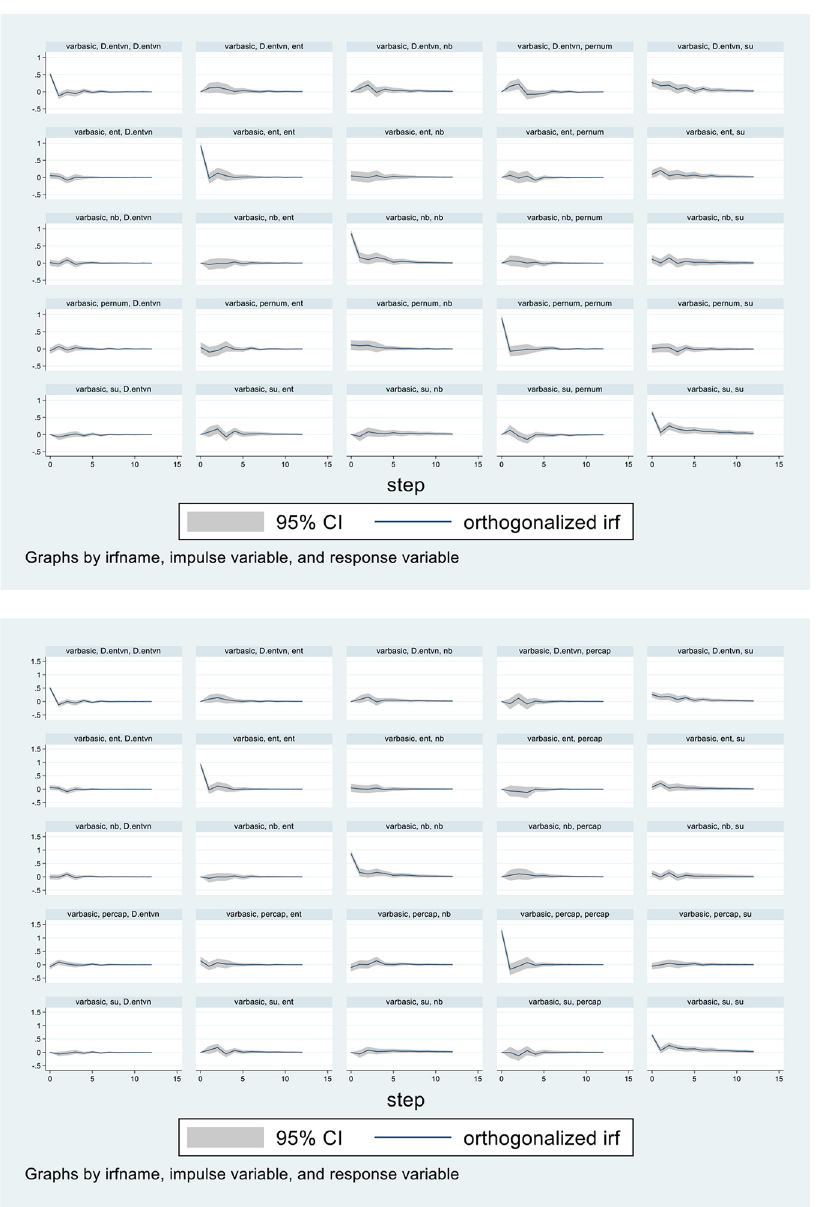
Figure A1. The impulse- response function